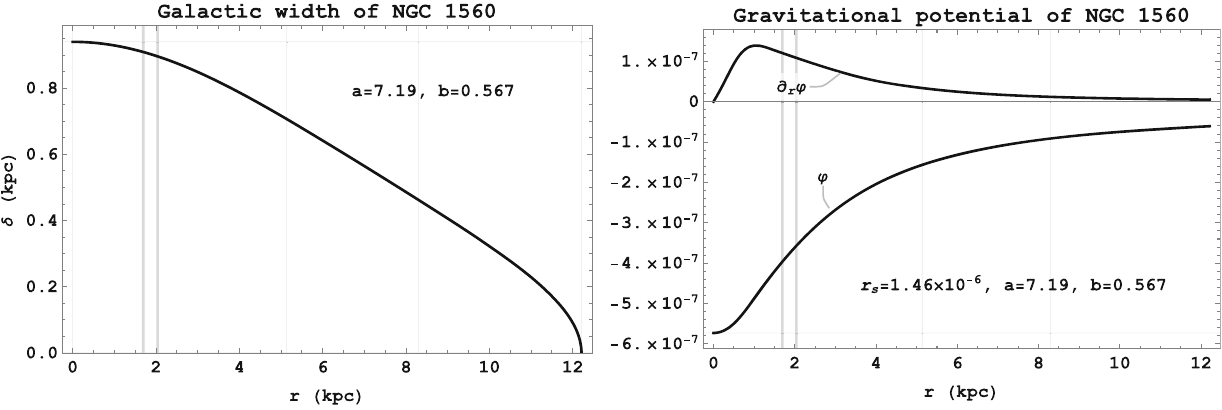
Fig. 5 The left-hand side graphic shows the calculated width of NGC 1560, and the right-hand side the normalized gravitational potential and its radial derivative along the equatorial plane. The thick vertical